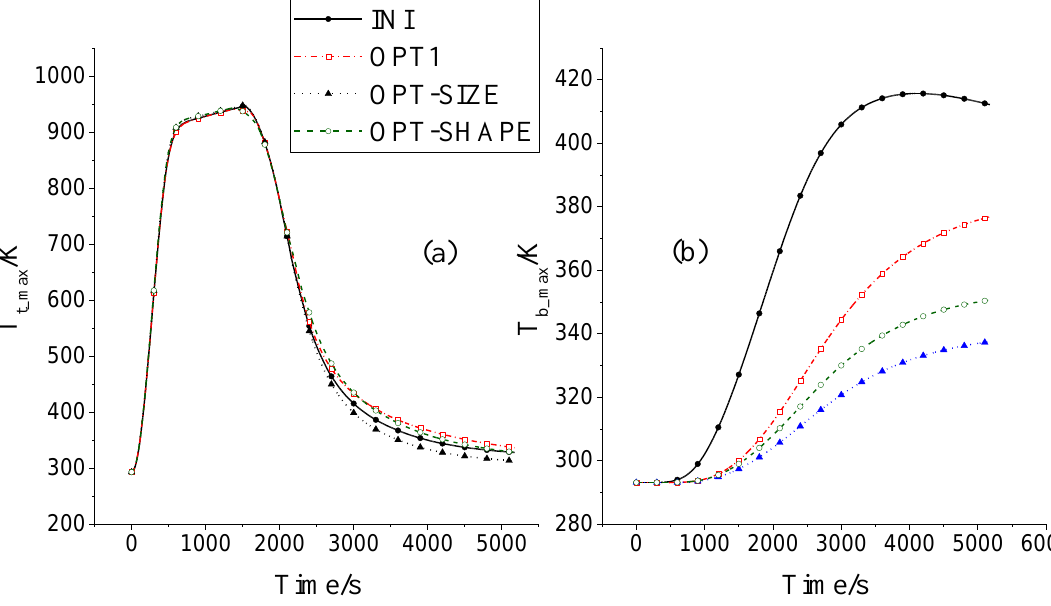
Figure 14. Maximum temperature evolution on ( a ) top surface and ( b ) bottom surface of the initial and optimized designs.